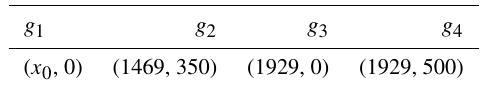
Table 5. Wave gauge locations (x,y) in millimeters, as shown in Fig. 6.